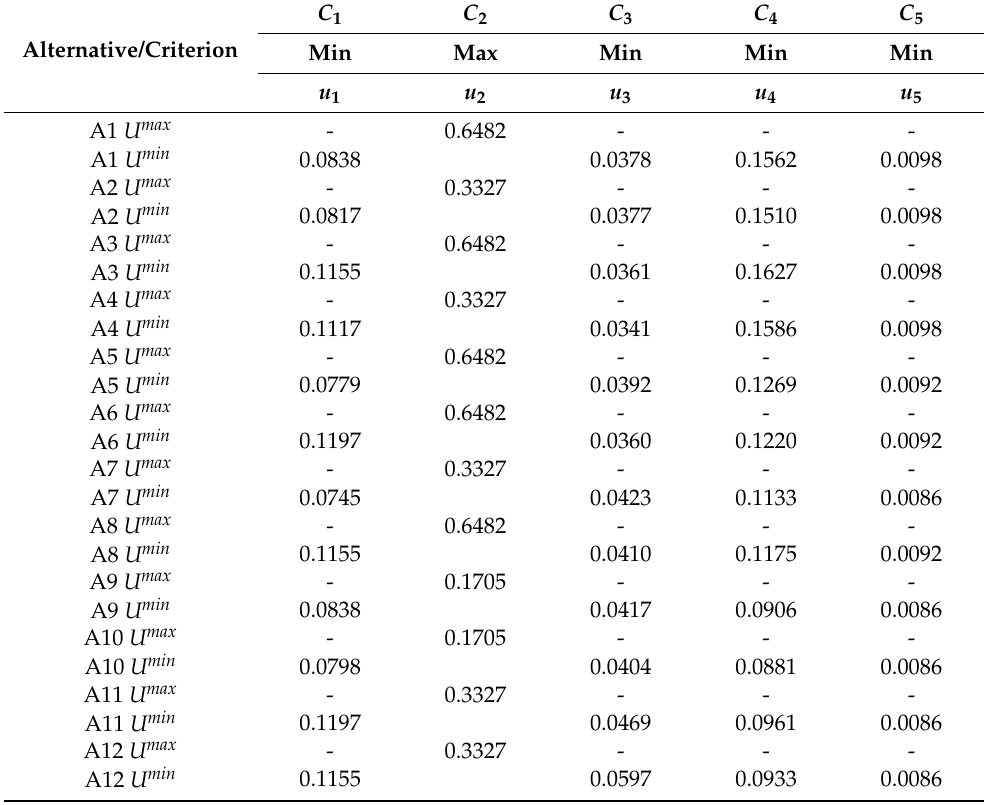
Table 15. Decomposition of